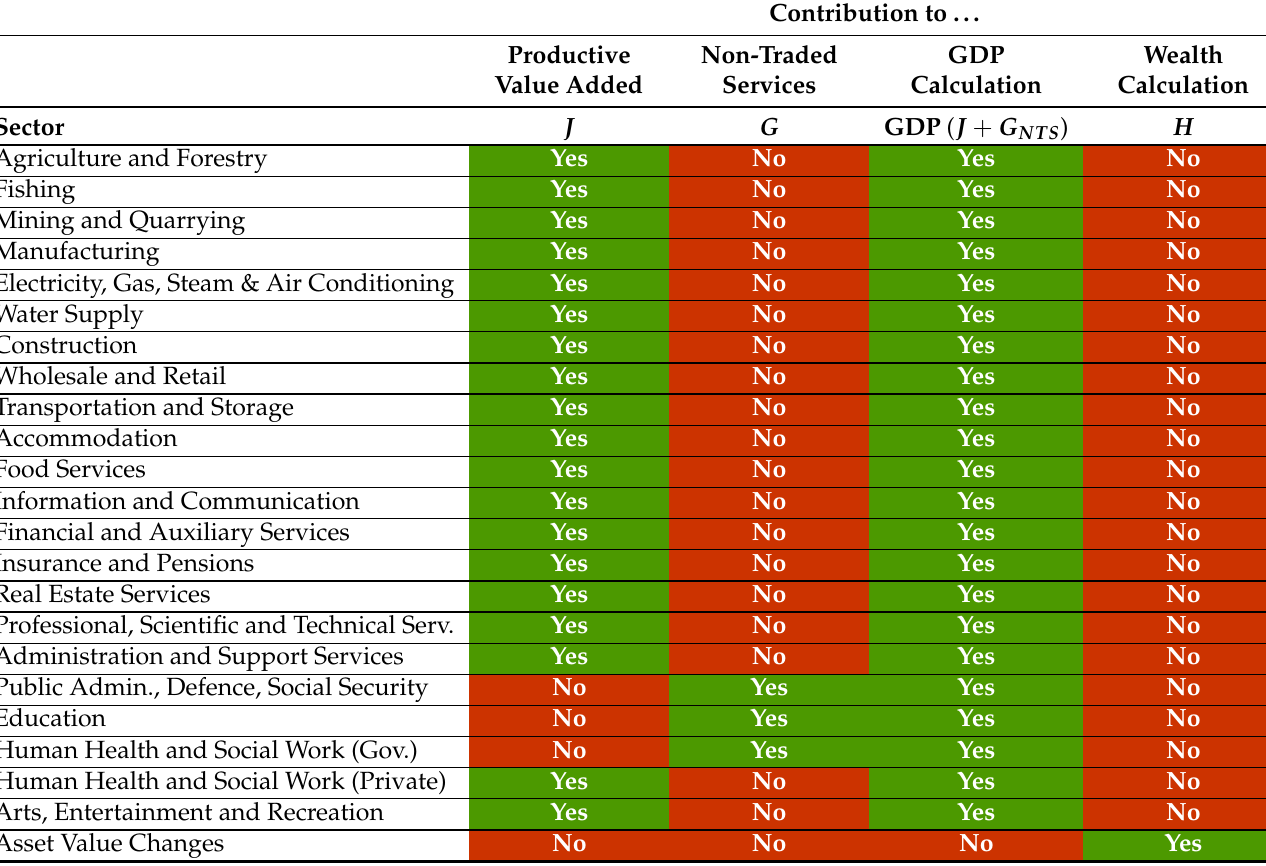
Table 2. Contribution of economic activities to the national accounts (IMF 2017).